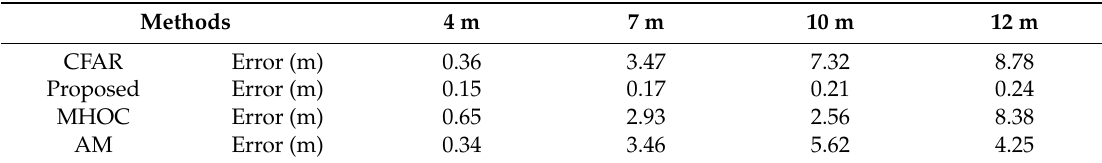
Table 2. Distance estimation with four different methods. CFAR: constant false alarm ratio, MHOC: multiple higher order cumulant, AM: advanced method.